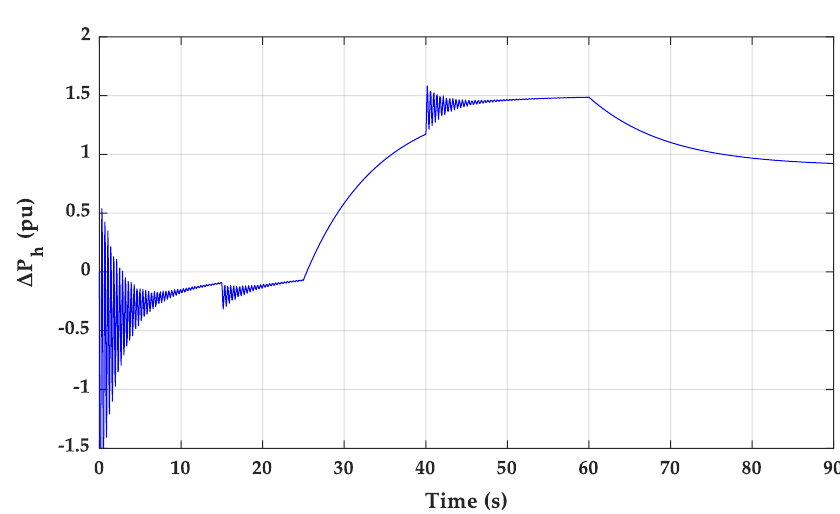
Figure 11. Response of the high-pressure part power deviation of the SGIB with feedback.